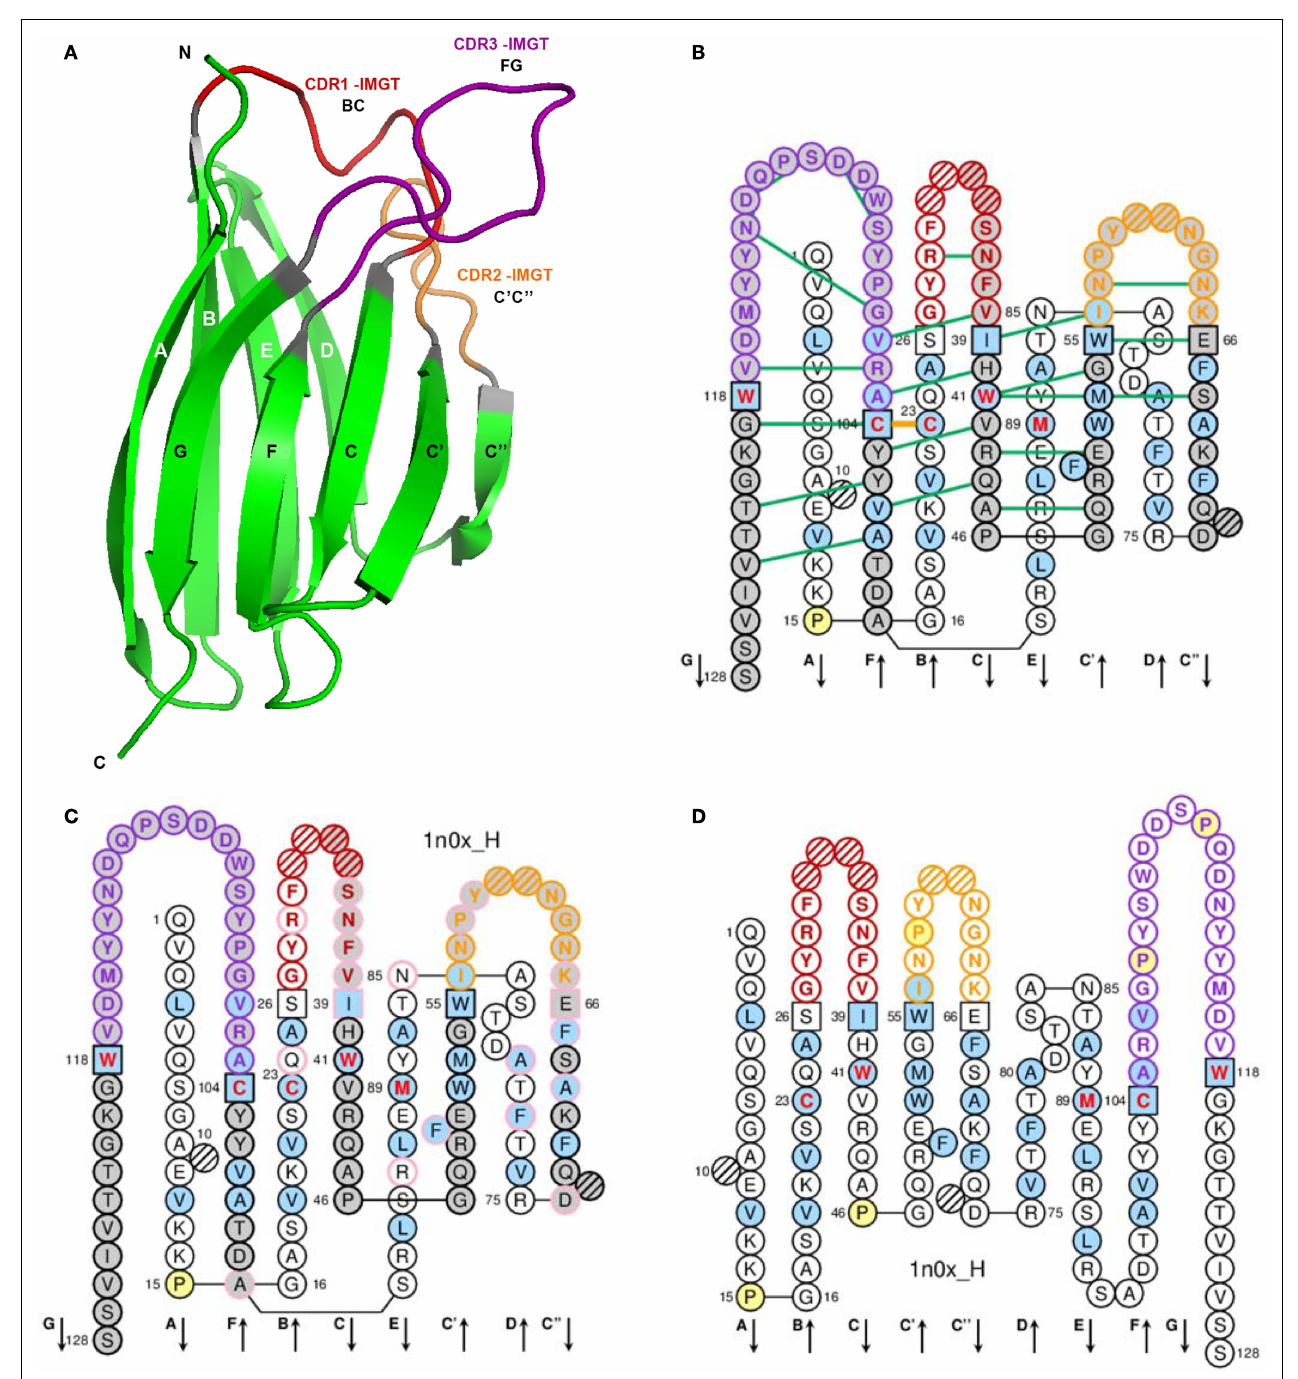
27, 28). Pink circles (online) indicate amino acid (AA) changes compared to the closest genes and alleles from the IMGT reference directory. (D) IMGT Collier de Perles on one layer. AA are shown in the one-letter abbreviation. All proline (P) are shown online in yellow. IMGT anchors are in square. Hatched circles are IMGT gaps according to the IMGT unique numbering forV-domain (64, 66). Positions with bold (online red) letters indicate the four conserved positions that are common to aV-domain and to a C-domain: 23 (1st-CYS), 41 (CONSERVED-TRP), 89 (hydrophobic), 104 (2nd-CYS) (62–66), and the fifth conserved position, 118 (J-TRP or J-PHE), which is specific to aV-DOMAIN